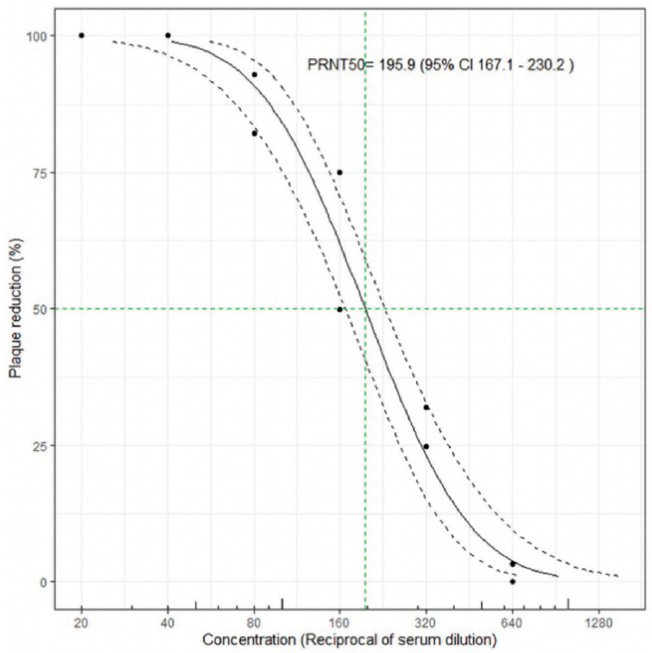
Figure 2. Representative PRNT50 analysis performed according to Bewley et al. [8].